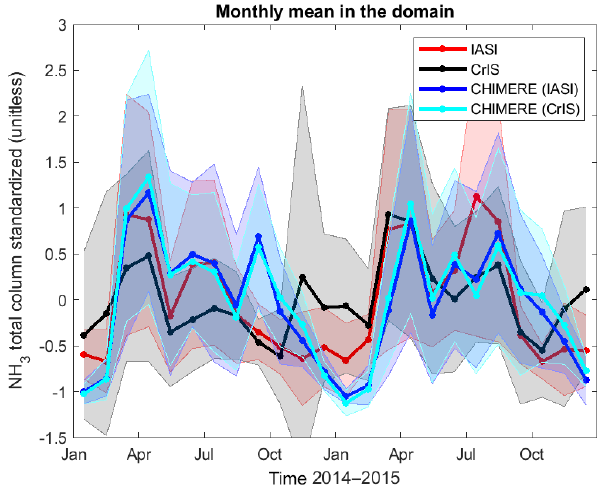
Figure 7. Correlation plots between monthly means of NH 3 stan- dardized concentrations derived from satellite observations (IASI in red and CrIS in black) and the CHIMERE outputs for March to August in 2014 and 2015. The 1 : 1 line is represented by the dashed line. Error bars represent the 1 σ standard deviation around the monthly